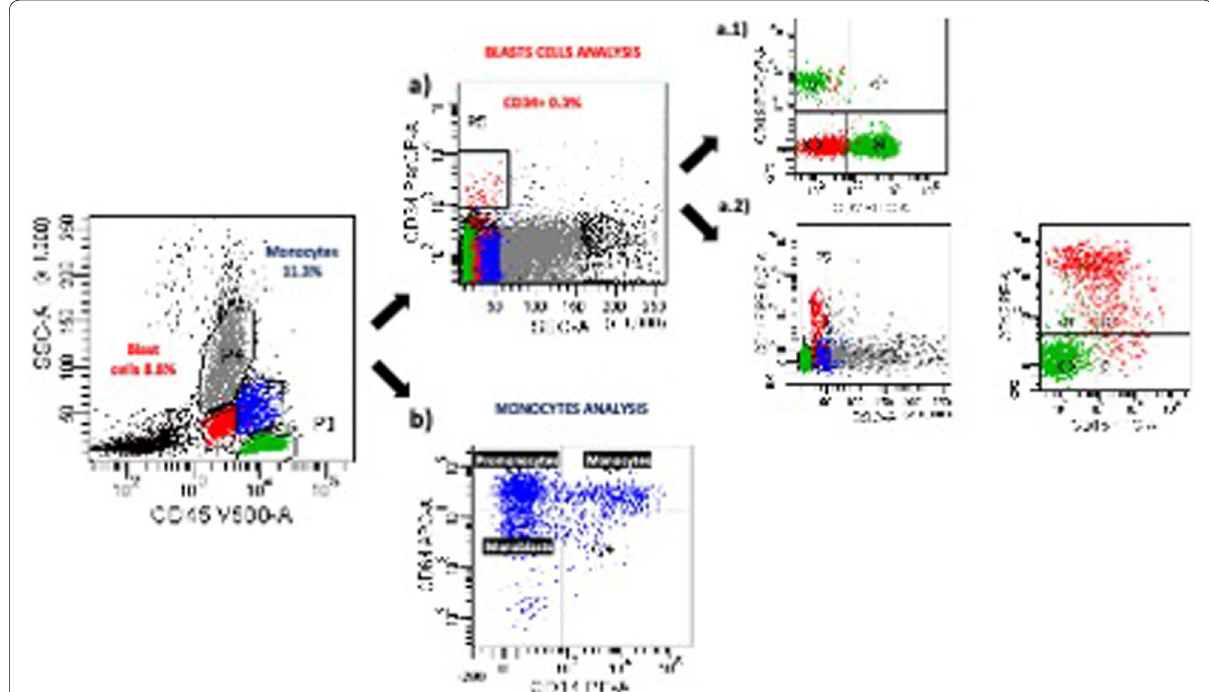
Fig. 3 Bone Marrow Immunophenotypic Analysis. a Blast Cells Analysis (CD45 low) solely 0.3%, not meeting criteria for acute leukemia. a.1 Blast do not express T o B lymphocyte markers. a.2 Expression of myeloid markers (CD 117 Analysis (CD45 high): Promonocytes (CD64 high, CD14 Neg) and monoblast (CD64 Neg, CD14 Neg) prevalence, both considered blast